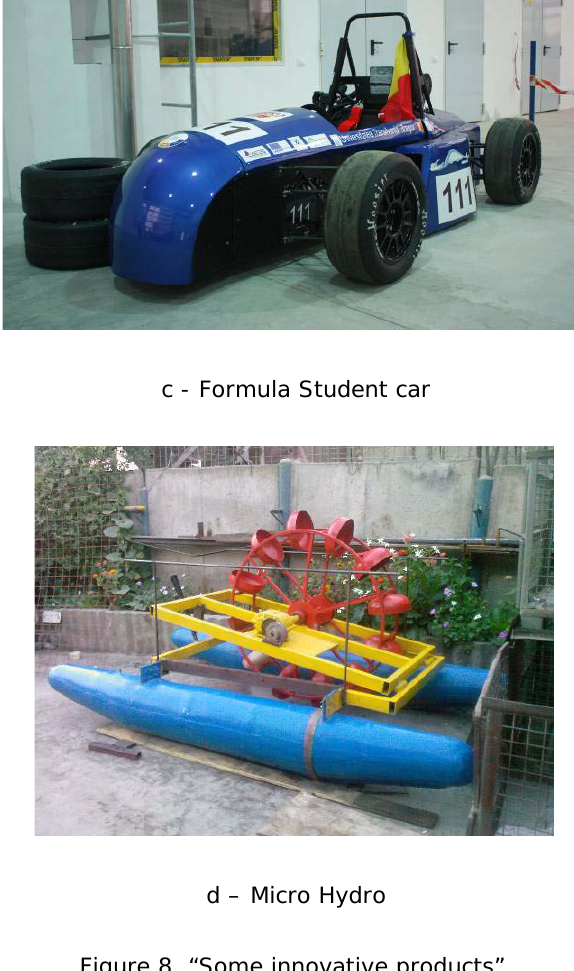
Figure 8. “Some innovative